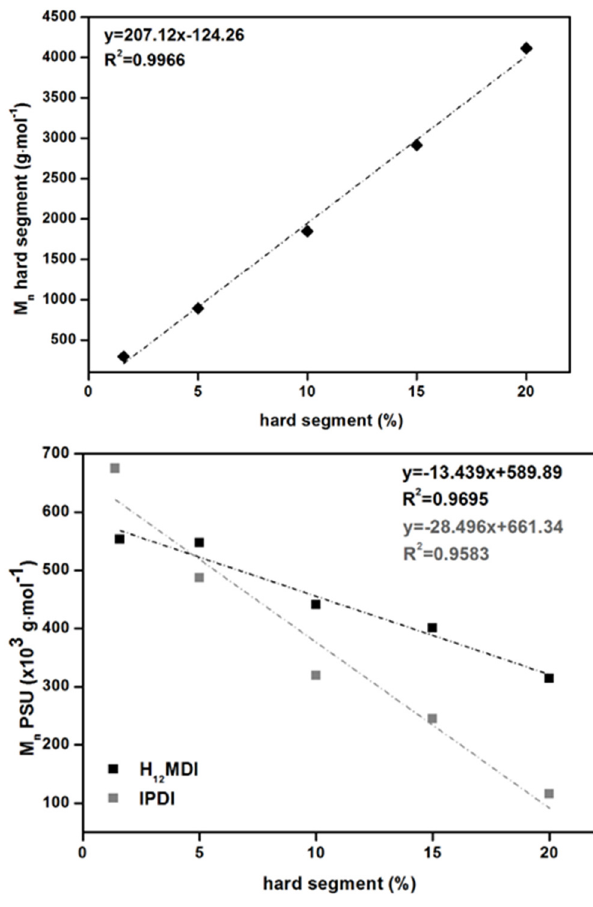
Figure A1. ( top ) Calculated average hard segment (HS) molecular weights as a function of HS content in PSU elastomers synthesized from H 12 MDI. ( bottom ) Number average molecular weights of PSU elastomers synthesized from H 12 MDI (black squares) and IPDI (grey squares) determined by SEC as a function of HS content.